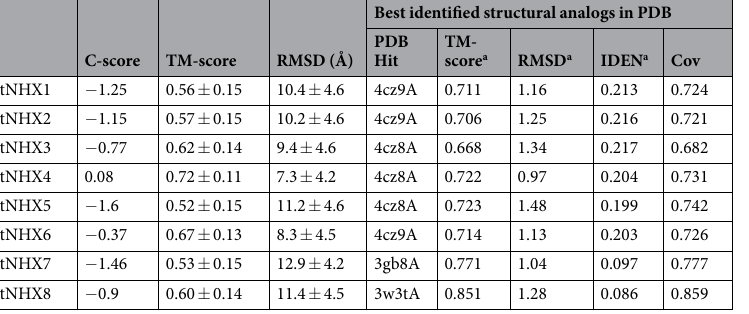
Table 3. Structural dependent modeling parameters for the PtNHX proteins. C-score [ − 5, 2] is the confidence of each model, higher value signifies a model with a higher confidence and vice-versa. TM-score and RMSD are estimated based on C-score and protein length following the correlation observed between these qualities. TM-score a is TM-score of the structural alignment between the query structure and known structures in the PDB library. RMSD a is the RMSD between residues that are structurally aligned by TM-align. IDEN a is the percentage sequence identity in the structurally aligned region. Cov represents the coverage of the alignment by TM-align and is equal to the number of structurally aligned residues divided by length of the query